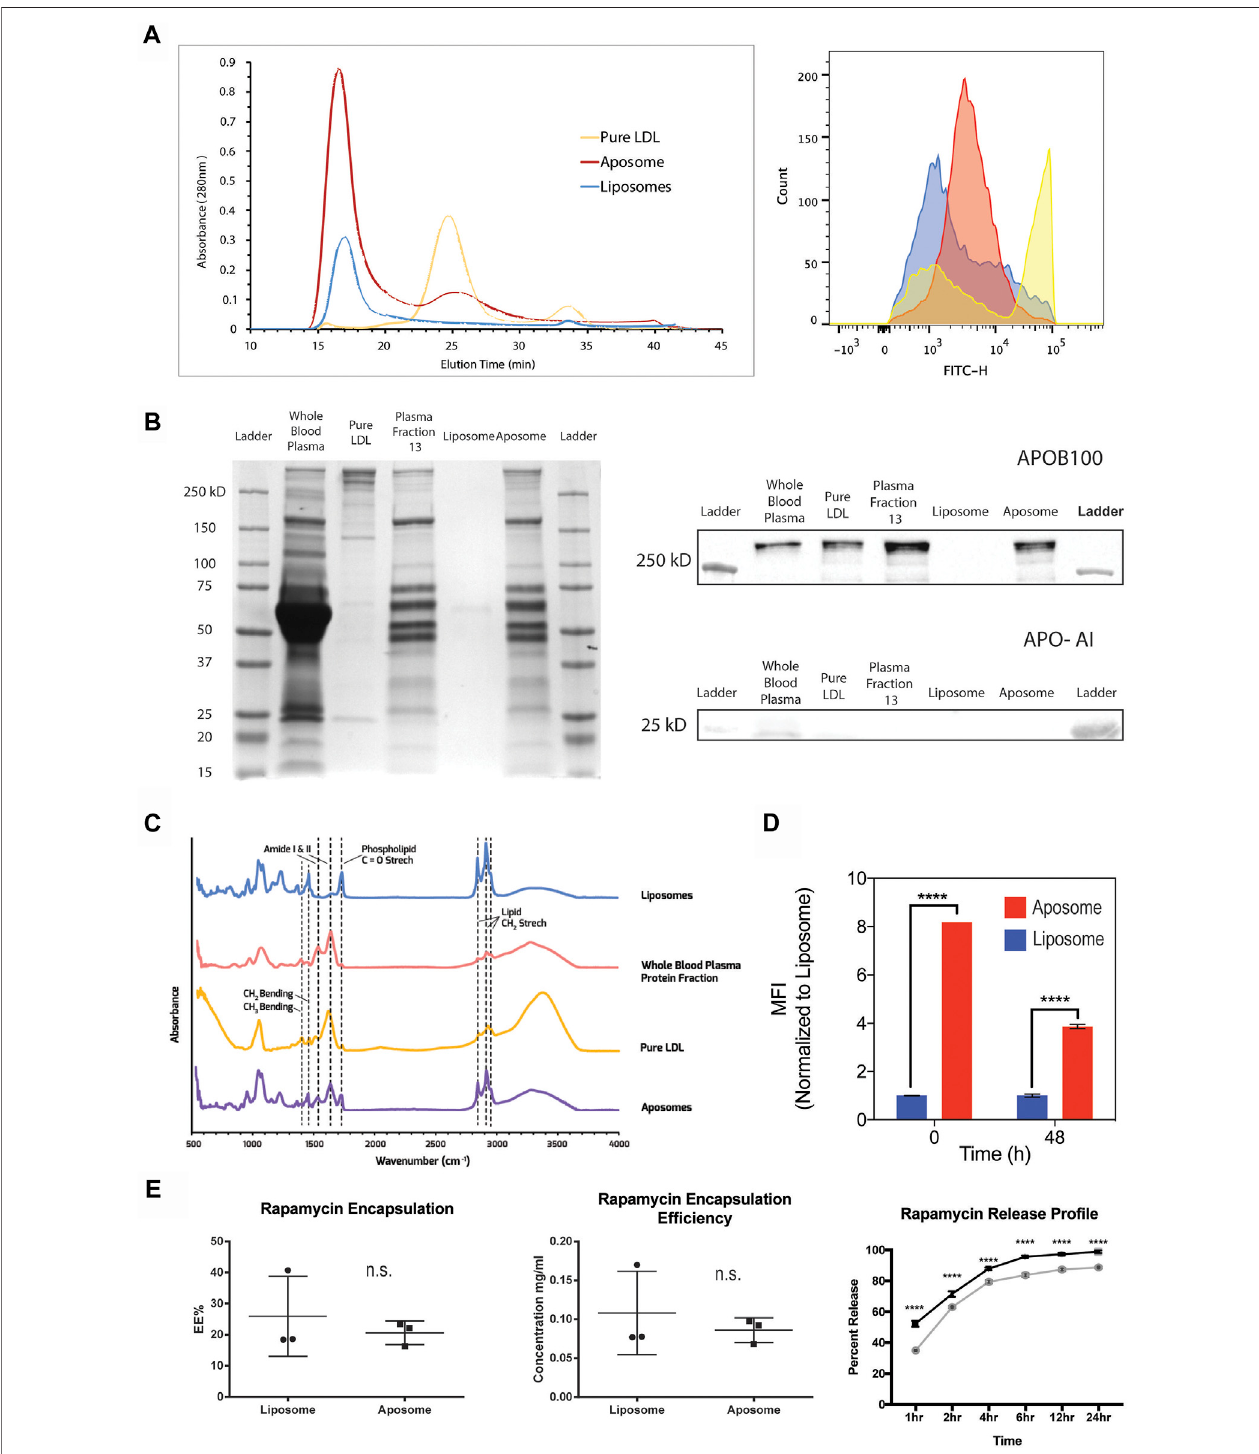
FIGURE 2 | - Aposome nanoparticles show higher apo-B100 enrichment of nanoparticles and prolonged drug release capability (A) FPLC pro fi le of aposomes shows retention ofapoB-100after sizeexclusion chromatography;increased absorbanceisindicative ofincreased protein presence. Corresponding fl owcytometry (G) of chromatographic peaks con fi rm retention of apoB-100 (B) SDS-PAGE of aposome NP maintains protein bands from plasma fractions, especially those above 250 kDa, indicative of apoB-100 presence. Western blot of aposome particles con fi rms apoB-100 presence in aposomes samples (C) FTIR of aposomes shows peaksthatareconsistentwithbothliposomesandpureLDL,corroborating,aswell,thepresenceofapo-B100inaposomes (D) Flowcytometryoflong-termretentionof apoB-100 aposomes shows that after 48 h aposomes retain LDL (E) Aposomes is capable to encapsulate a small hydrophobic molecule (i.e., Rapamycin) with a prolonged release curve as was assessed by